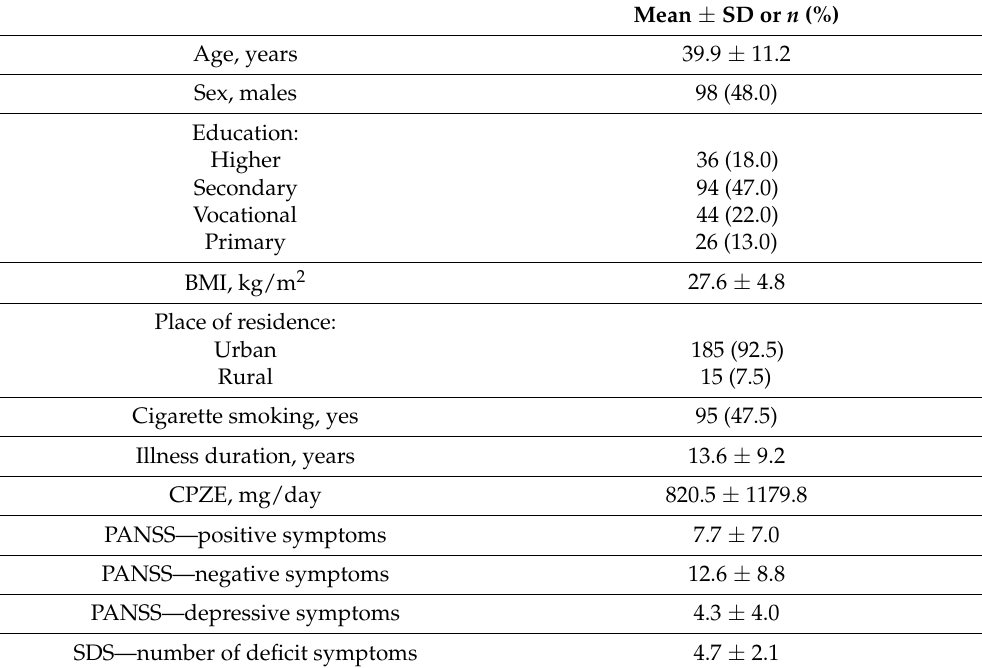
Table 2. General characteristics of the sample ( n =